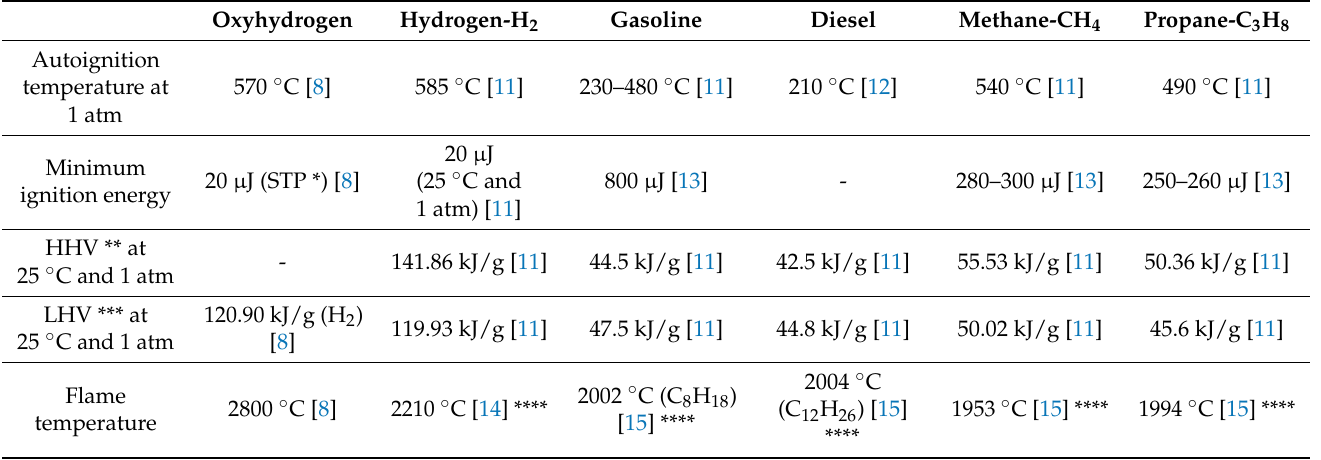
Table 1. Properties of oxyhydrogen, H 2 , gasoline, diesel, methane and propane. Oxyhydrogen Hydrogen-H